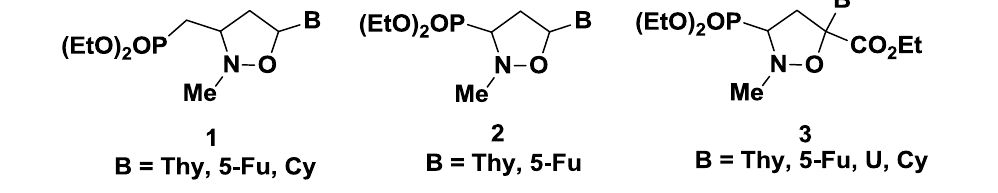
Figure 2. Phosphonated N,O -nucleosides.